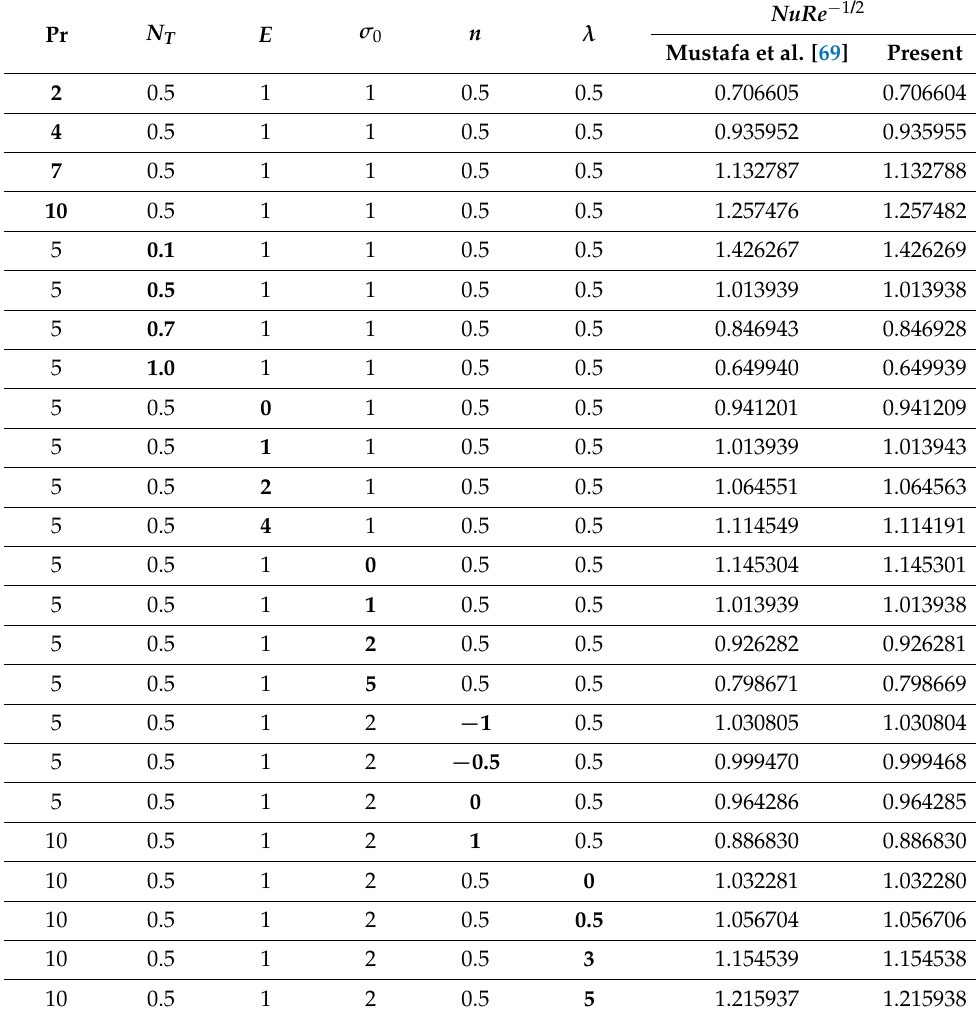
Table 1. Correlation of Nusselt number M = B N = N B = 0.5, Sc = 5, and δ 0 = 1.